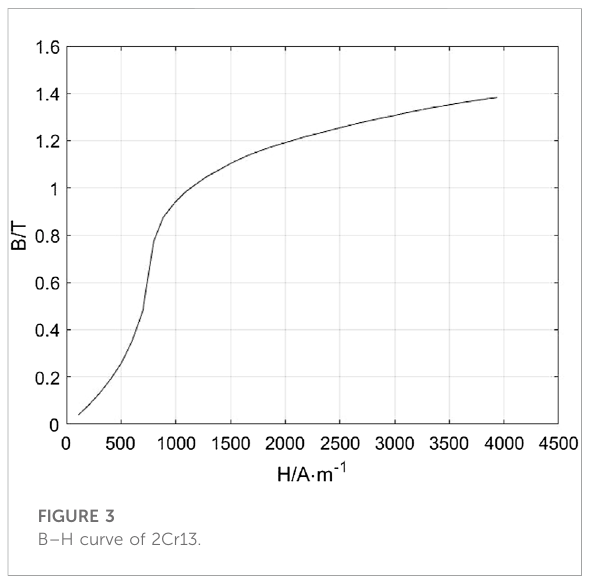
FIGURE 4 Import structure